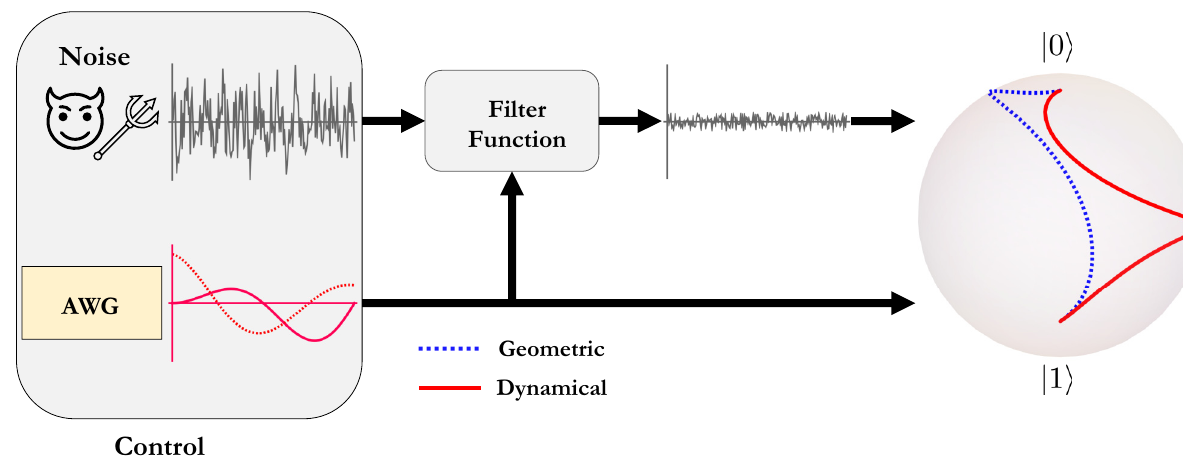
FIG. 1. A schematic diagram summarizing our main result. The qubit’s state is manipulated by applying control fields, e.g., using an arbitrary waveform generator (AWG), that are subject to some noise process (schematically represented here by a demon). The control fields determine an object called a filter function that characterizes the control’s sensitivity to noise. In this diagram, the control is robust since it suppresses the effects of noise. Geometric gates are often expected to be more robust against noise than dynamical gates due to the geometric properties of their phase. Our main result shows that, for common types of noise in the absence of control constraints, one can actually construct different control fields that produce evolution paths with accrued phases ranging from purely geometric to purely dynamical that all result in the same gate and noise